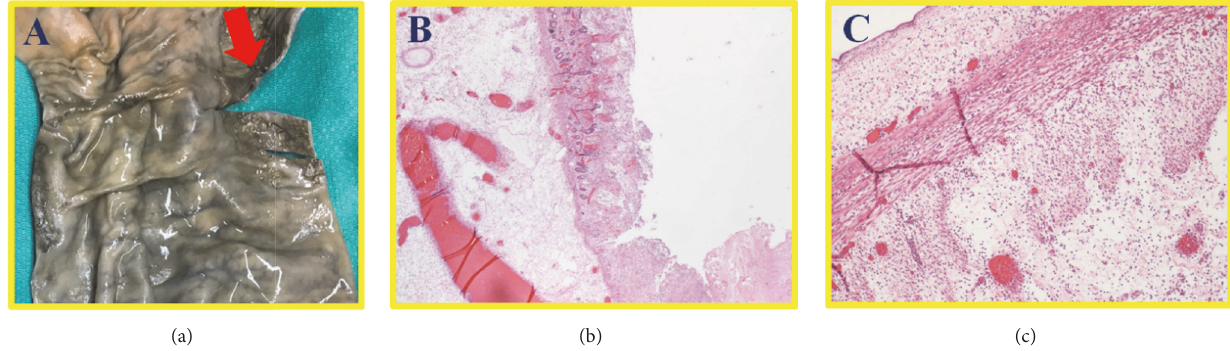
Figure 2: Perforation site in the ascending colon. (a) Gross image of perforation site in ascending colon. (b,c) H&E staining revealed the extensive mucosal necrosis or ulceration and overlying fibrinopurulent exudate.